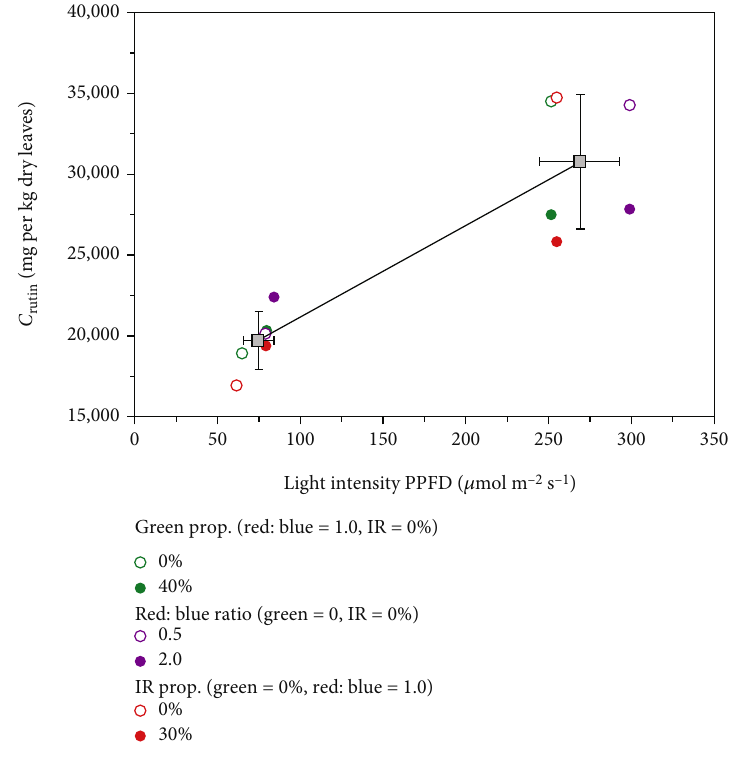
Figure 4: Concentration of rutin as a function of the light intensity by variation of light components. Dots with error ranges present the mean values of the rutin concentrations regarding the PPFD levels of 75 and 275 μ molm -2 s -1